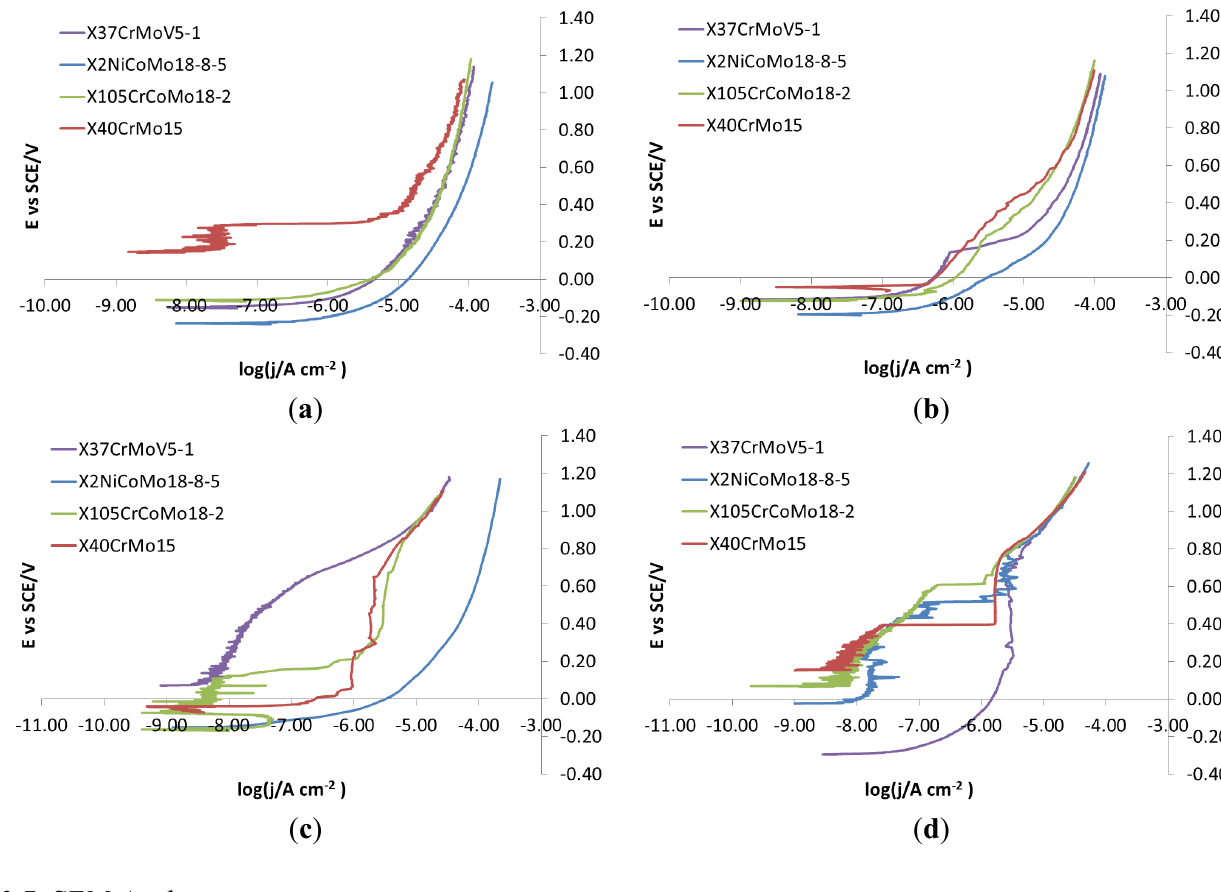
Figure 20. Electro-eroded finish: polarization curves on different steels. ( a ) Bare; ( b ) Monolayer; ( c ) Multilayer 4; ( d ) Multilayer 8.